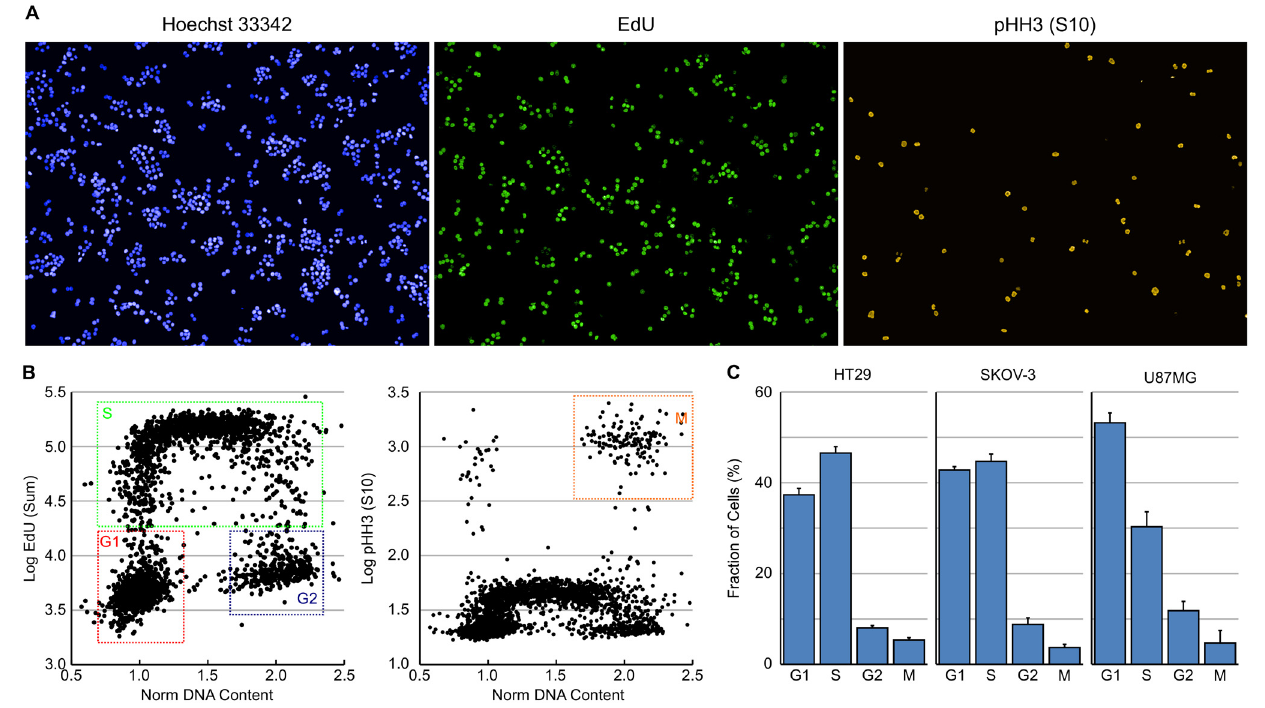
Fig 2. Multiparametric analysis of cell cycle distribution. (A) Example images demonstrating DNA staining with Hoechst 33342, EdU incorporation and pHH3 (S10) expression in untreated HT29 cells. (B) Plots of DNA content versus log EdU content and DNA content versus log mean pHH3 (S10) expression to determine the major cell cycle phases in asynchronous HT29 cells. (C) Cell cycle distribution for asynchronous HT29, SKOV-3 and U87MG cells determined from multiparametric high-content images. Values are the average of 8 technical replicates ± SD.